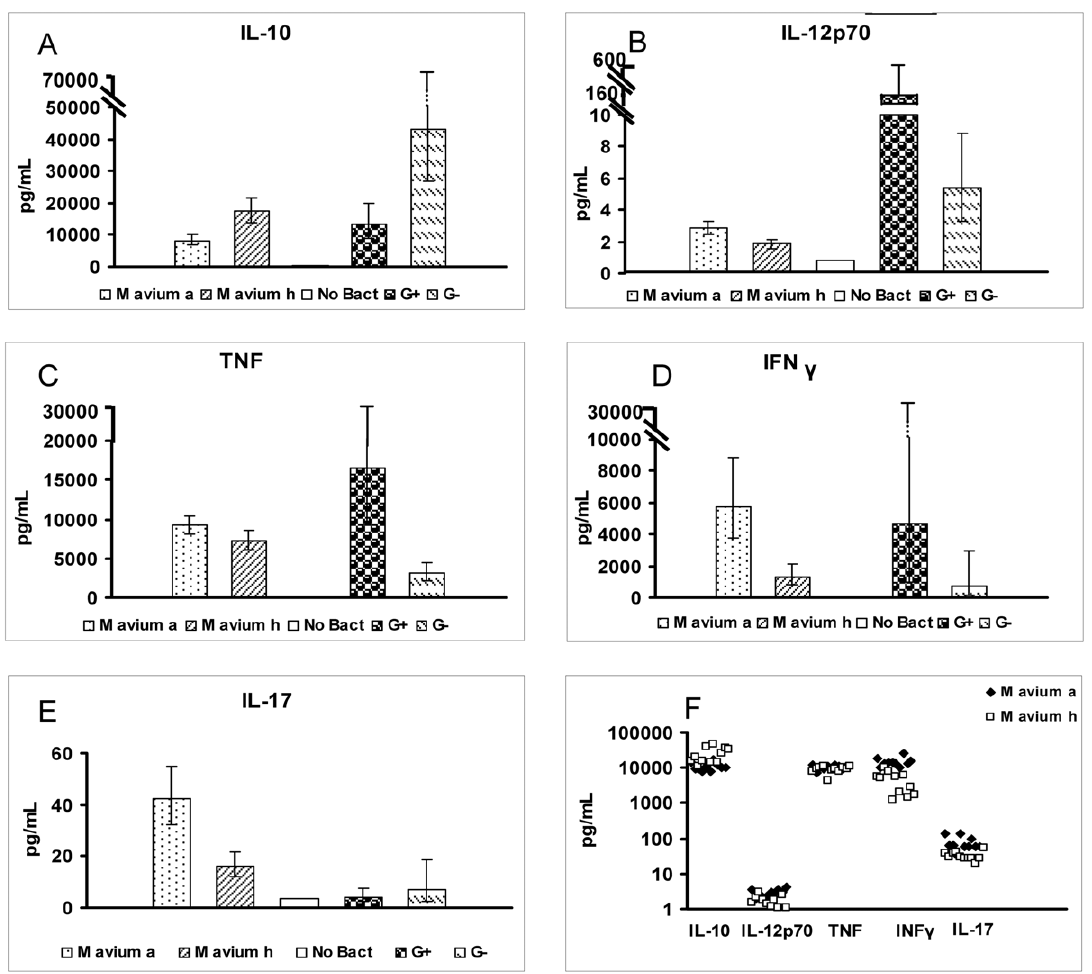
Figure 1. Geometric means of cytokine levels: (A) IL-10, (B) IL-12p70, (C) TNF, (D) IFN- c , (E) IL-17. Cytokine levels in pg/mL after stimulation with 5 6 10 7 inactivated bacteria/mL of PBMCs from six healthy blood donors are shown. IL-10, IL-12p70 and TNF were measured after a 24 h stimulation; IFN- c and IL-17 after five days of stimulation. Geometric means and 95% confidence intervals are shown. F) Arithmetic means of cytokine levels. The arithmetic mean of the cytokine level (pg/mL) for each individual isolate is shown. M avium a= Mycobacterium avium avium ; M avium h= Mycobacterium avium homunissuis ; No Bact=no bacteria; G + = Streptococcus mitis ; G 2 = Escherichia coli . Note that Figure F is shown on a logarithmic scale.